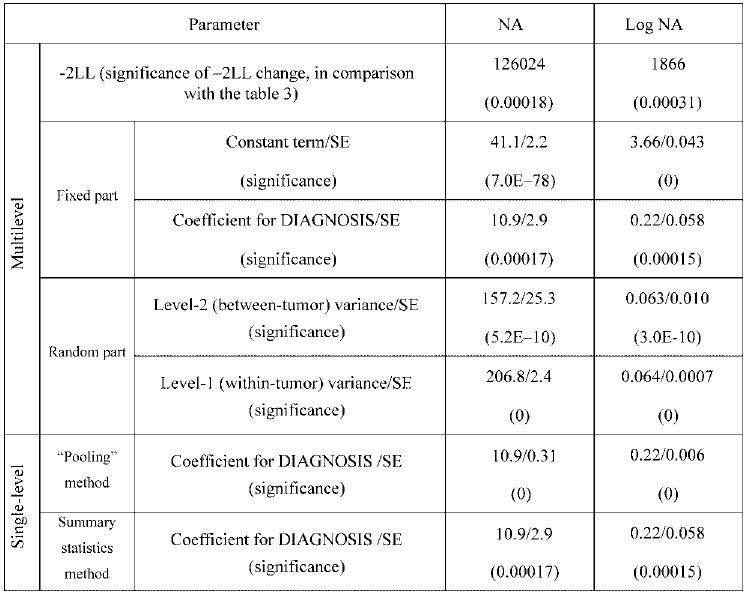
Model for NA and log NA with DIAGNOSIS as fixed coefficient